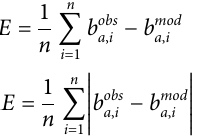
Frontiers in Earth Science |